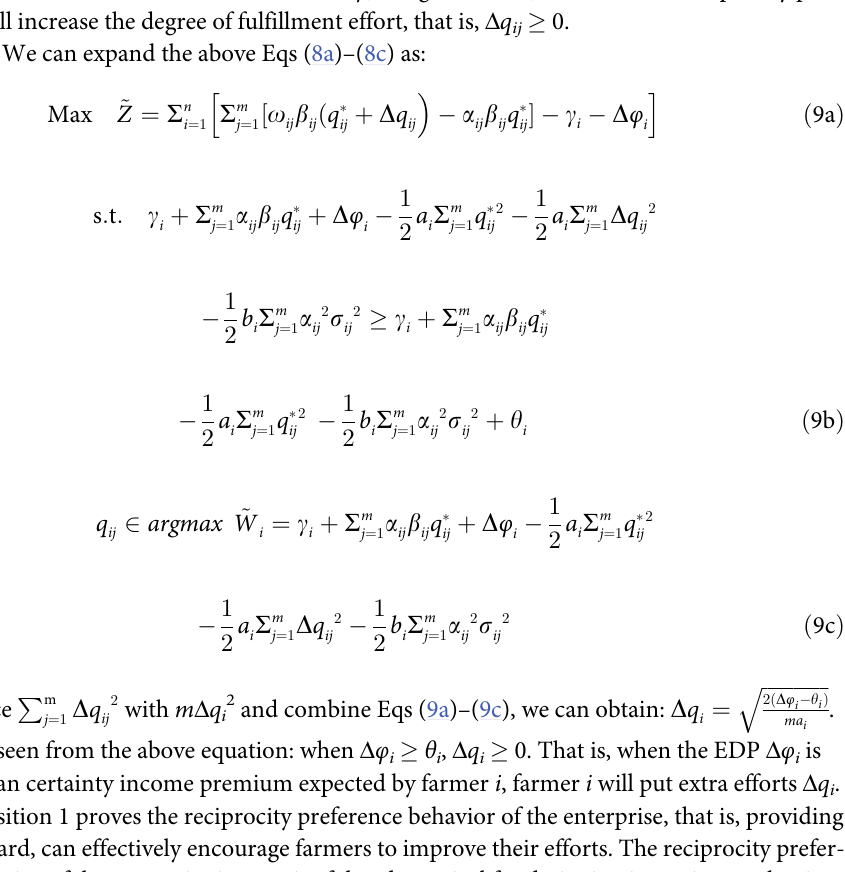
ffiffiffiffiffiffiffiffiffiffiffiffiffi q 2 ð D φ i (cid:0) y i Þ ma i